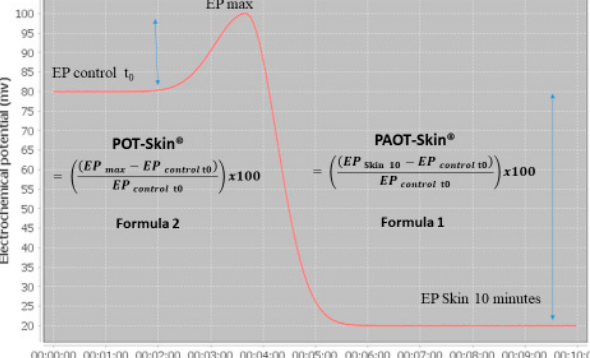
Figure 2. Kinetic curve of electrochemical potential changes during reaction of skin antioxidants and oxidants with oxidized / reduced iron forms (mediator M). PAOT-Skin Score ® was calculated as being the ratio PAOT-Skin ® / POT-Skin ® . EP control T 0 = baseline potential of oxidized / reduced mediator M being at 80 nV.